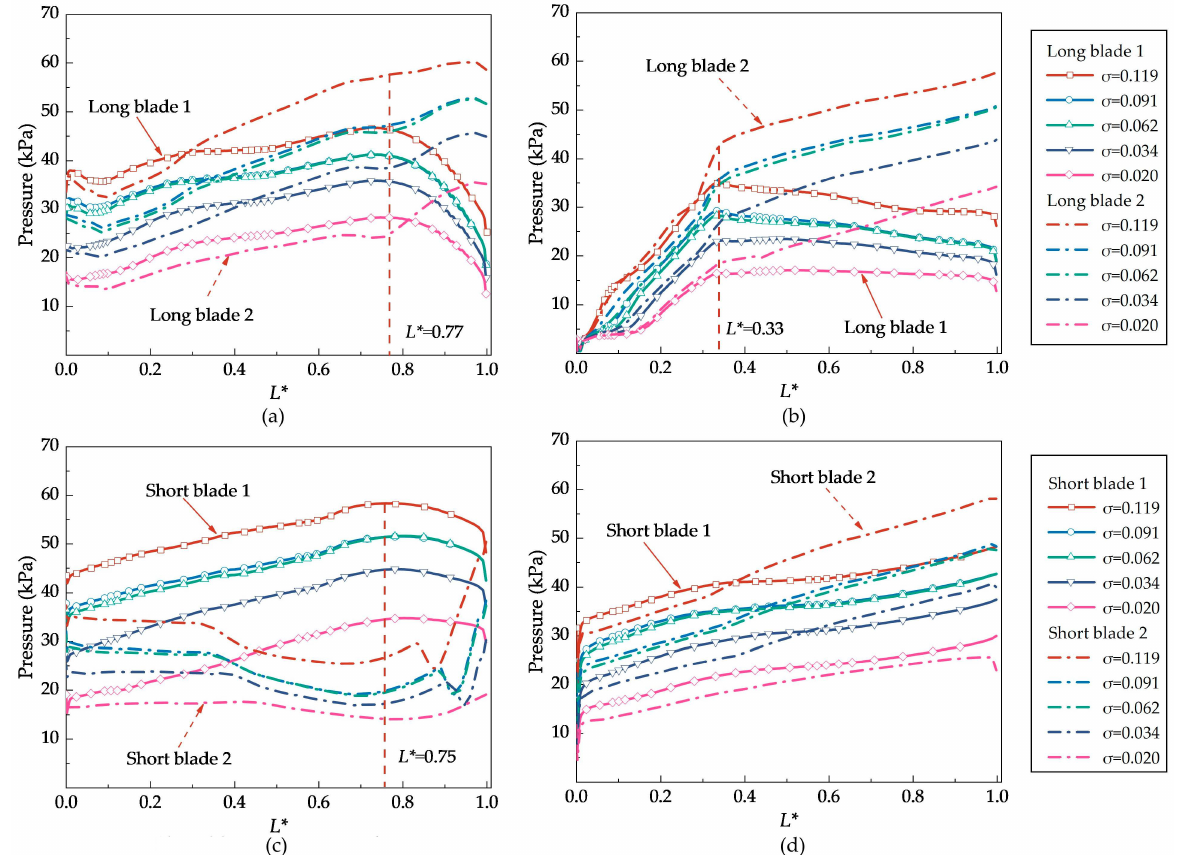
Figure 11. Effect of cavitation coefficient on blade load distribution under TC = 0.3 mm: ( a ) Long blade pressure surface; ( b ) Long blade suction surface; ( c ) Short blade pressure surface; ( d ) Short blade suction